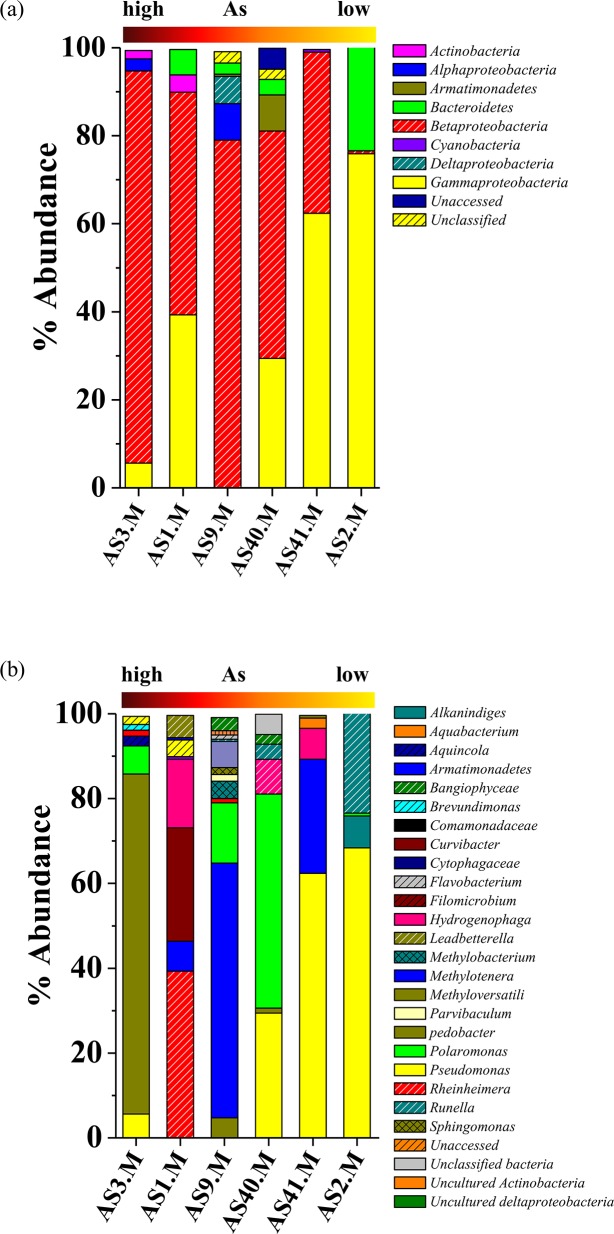
Distribution of major phylogenetic groups of bacteria as detected in clone libraries.Abundance of bacterial groups is plotted with respect to their affiliation at (a) phylum level and (b) genus level. The horizontal bar indicates gradient of As concentrations as detected in six samples.